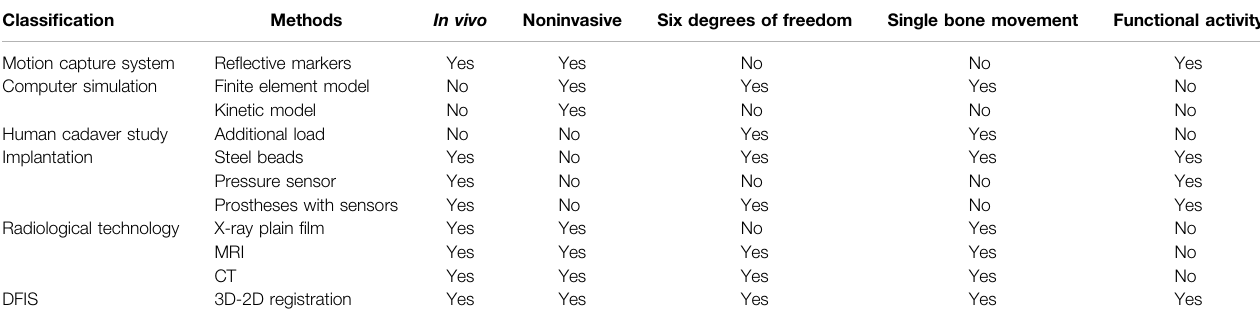
TABLE 1 | Comparison of DFIS with other biomechanical methods. Classi fi